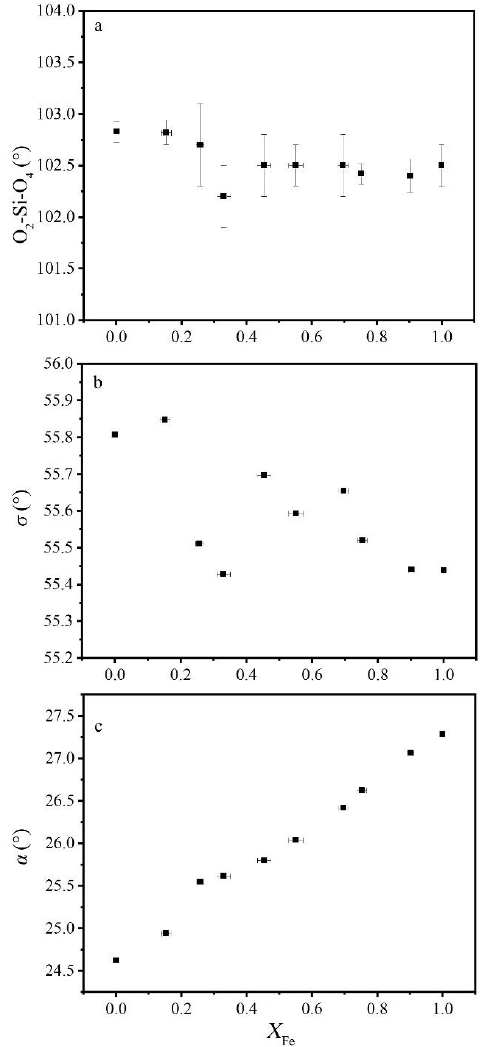
Figure 8. ( a ) Angle variance of O 2 –Si–O 4 in tetrahedron, ( b ) the octahedral distortion parameter σ (Euler and Bruce (1965) [34]), and ( c ) the tetrahedral rotation parameter α (Born and Zemann (1964) [34]) as a function of composition for grossular–andradite solid solution.